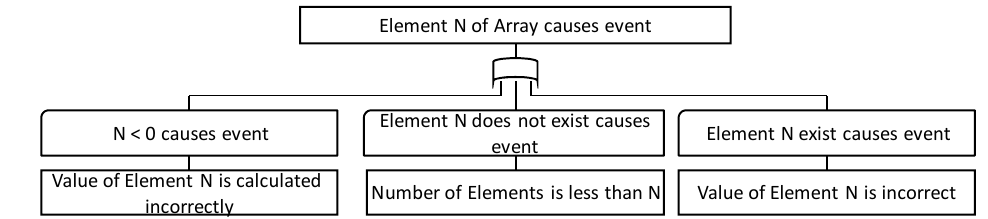
Figure 11. FTT for Figure 11. FTT for array.